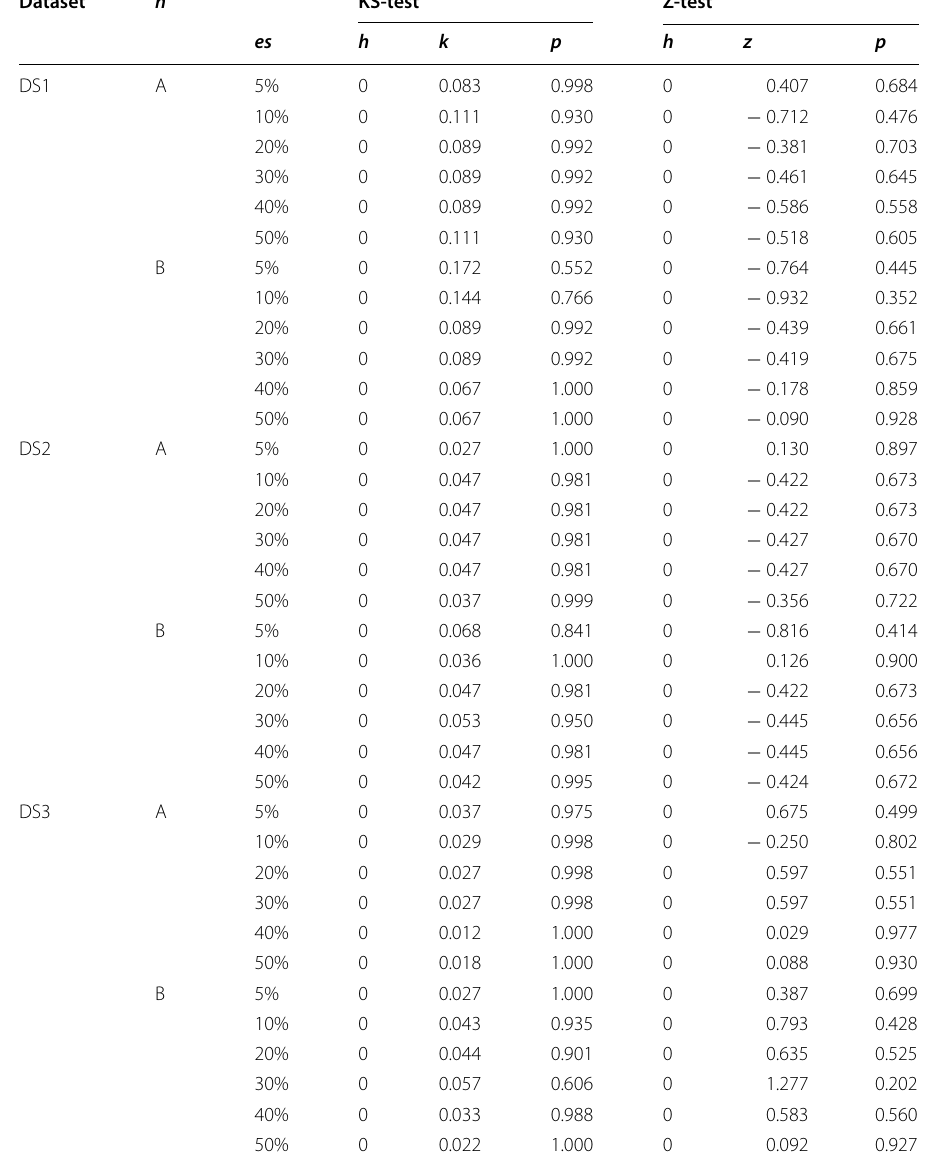
Table 5 Results of two-samples KS-test and Z-test on two distance distributions among the actual cluster centers and the estimated cluster centers of the synthetic datasets by the RSPCE algorithm